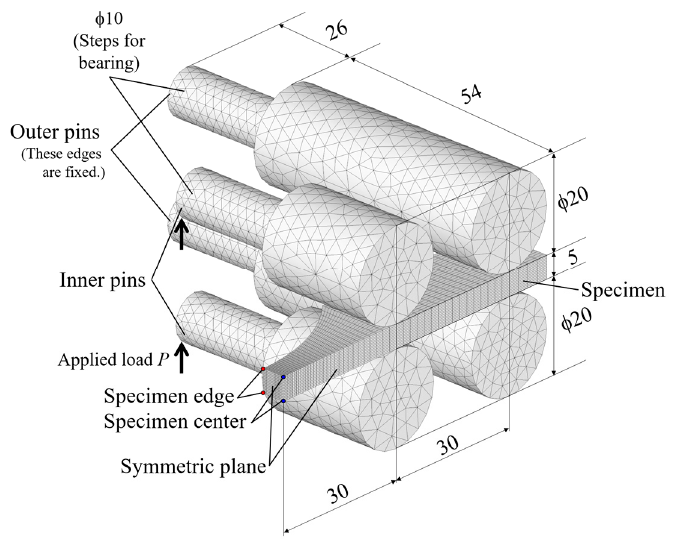
Figure A1. Finite element model and boundary conditions of a four-point bending specimen with thicknesses of 5 mm.